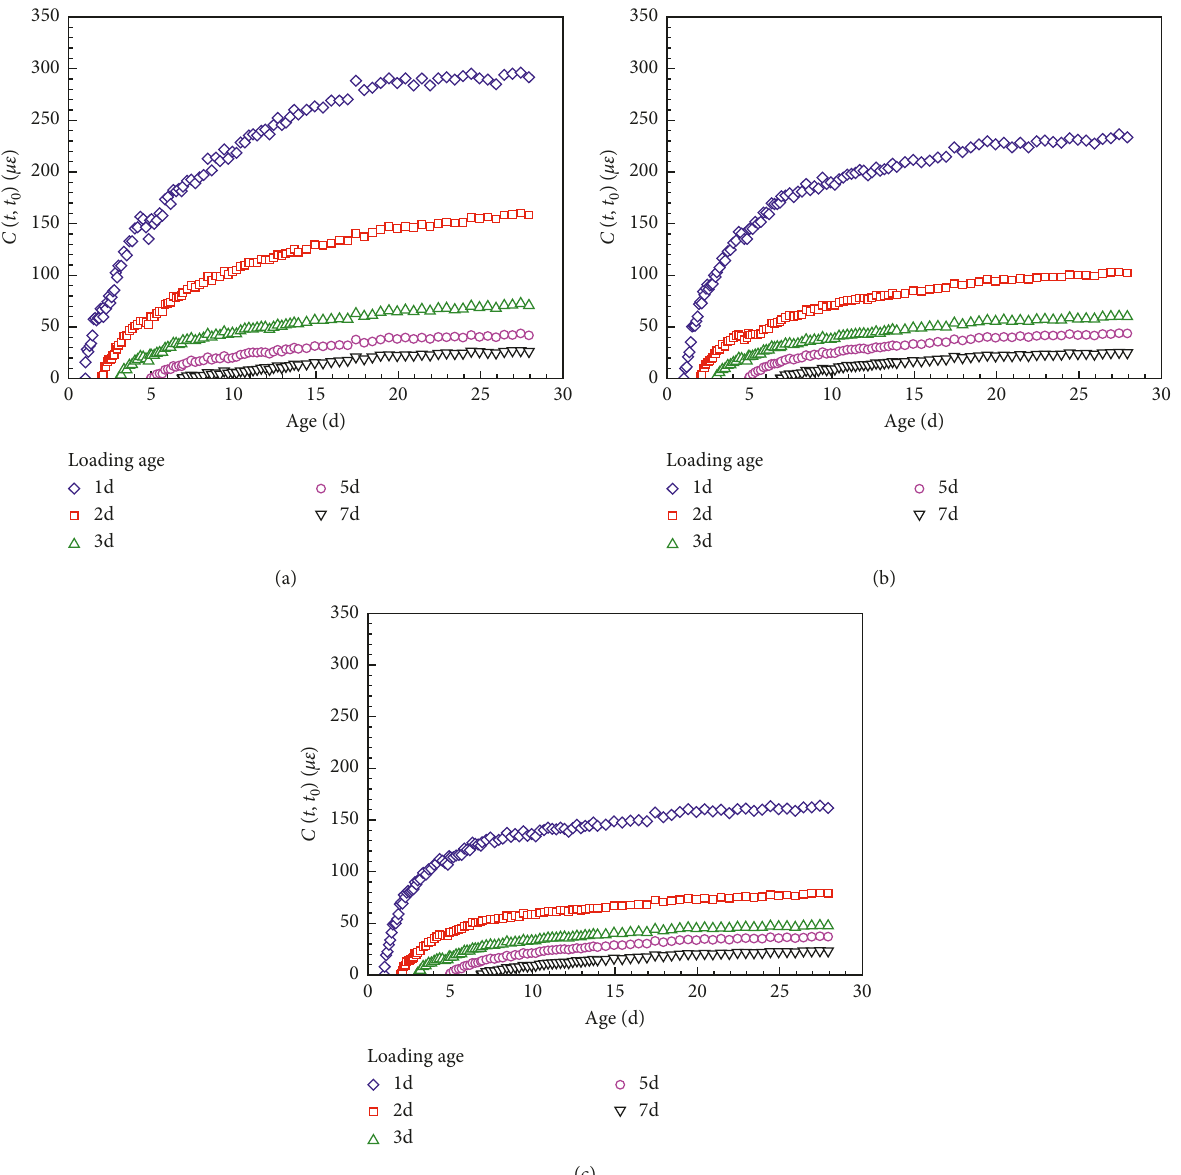
Figure 7: Specific creep of trinary binder group at different loading ages. Stress/strength ratios: (a) 0.2, (b) 0.3, and (c)